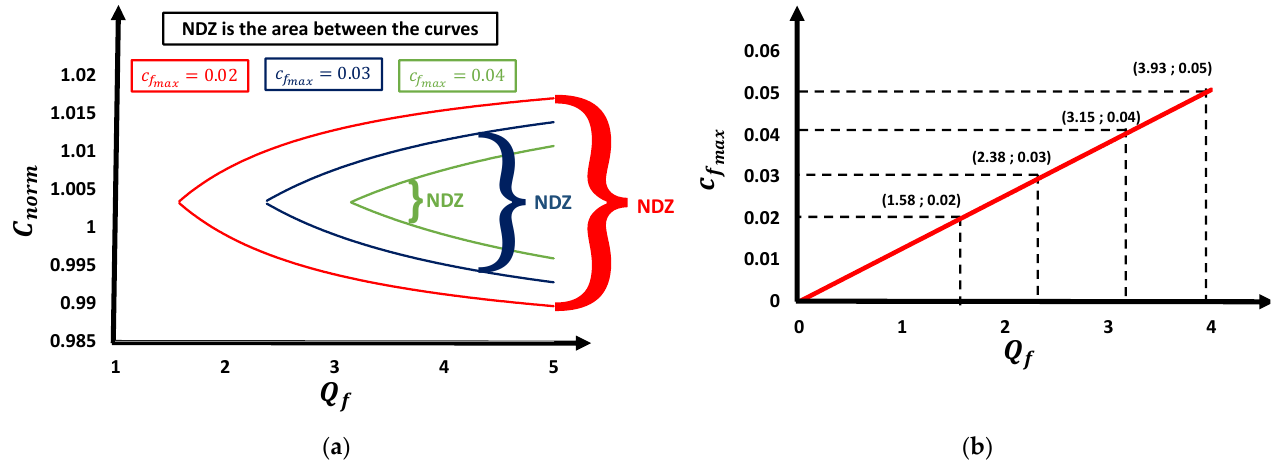
versus 𝑐 . 𝑓 𝑓 𝑚𝑎𝑥 . . 𝑚𝑎𝑥 max